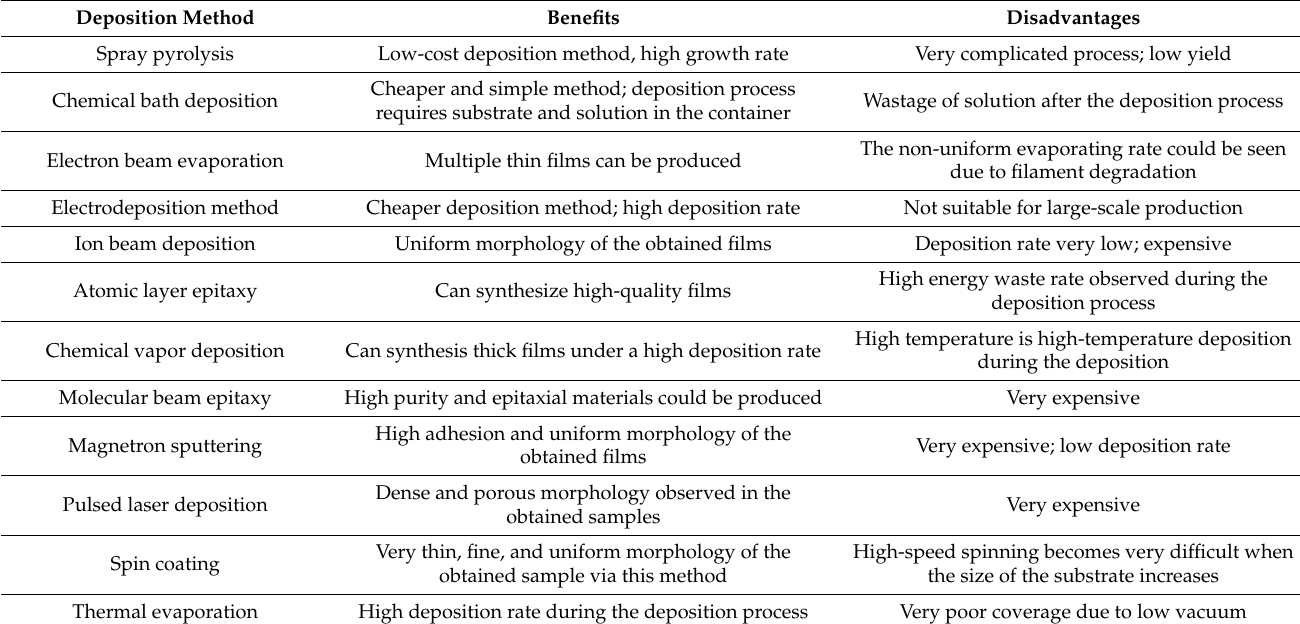
Table 1. The advantages and disadvantages of various deposition